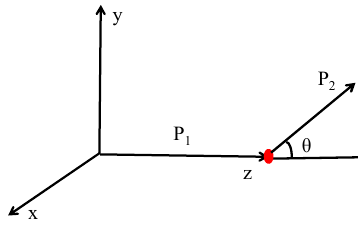
Figure 2. Scattering pattern of emitted photons.